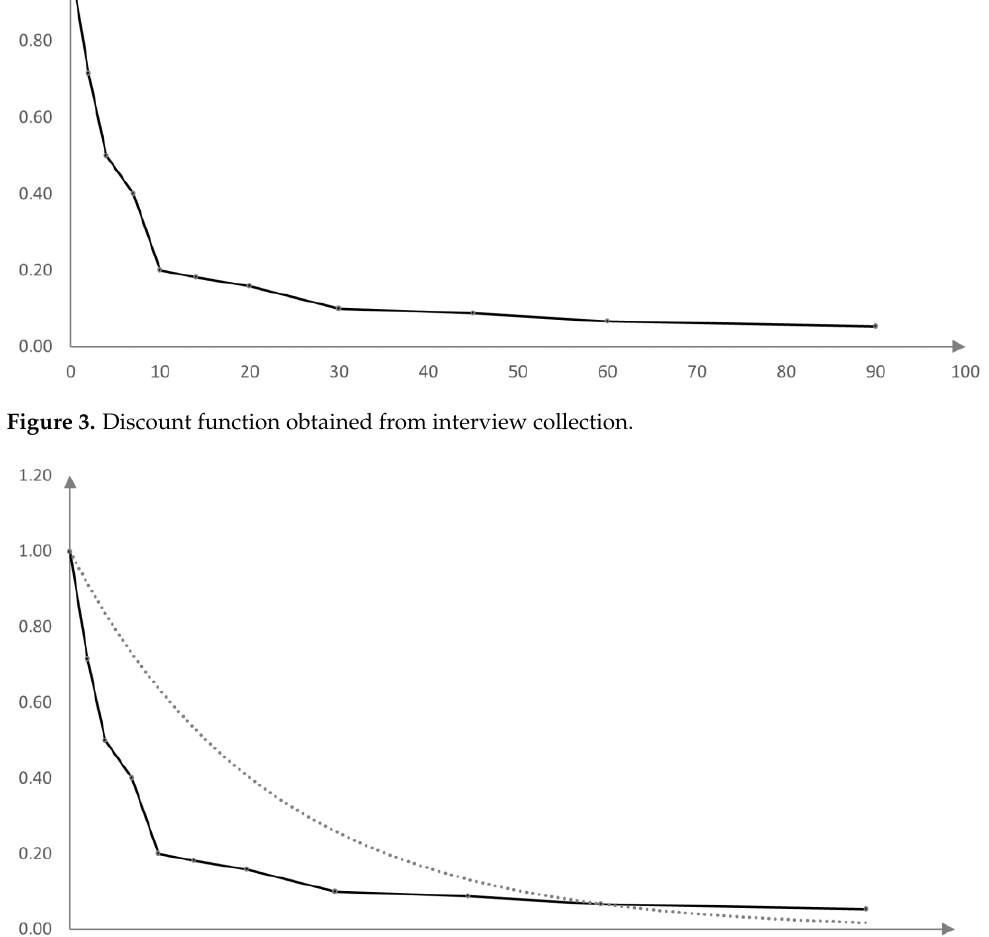
Figure 3. Discount function obtained from interview collection.